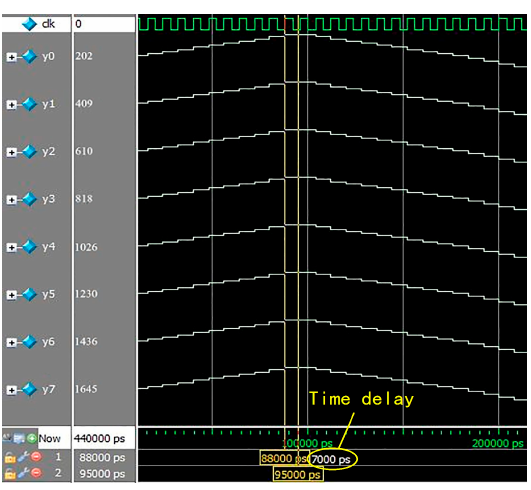
Figure 8. Simulation of 8× interpolation CIC filter parallel algorithm.